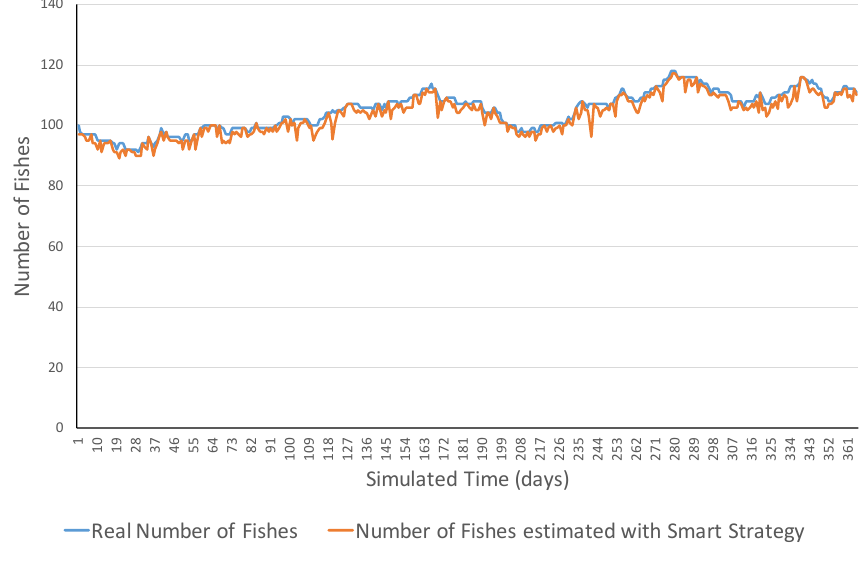
Figure 3. Simulation evolution of a neutral ecosystem with the smart strategy.